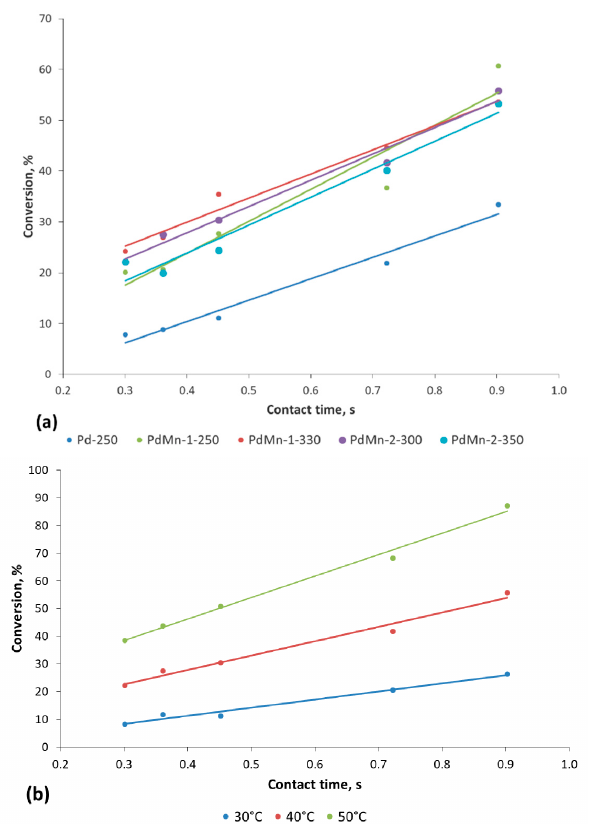
Figure 6. Acetylene conversion vs. contact time: ( a ) for the Pd-Mn / Al 2 O 3 catalysts; ( b ) for PdMn-2-300 at 30, 40, and 50 °C.